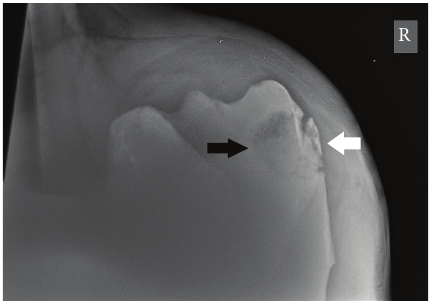
Figure 1: Cranioproximal-craniodistal oblique projection on the humeral tubercles: a 4 cm long partly detached bony fragment (white arrow) lateral to the radiolucent area (black arrow) is visible.